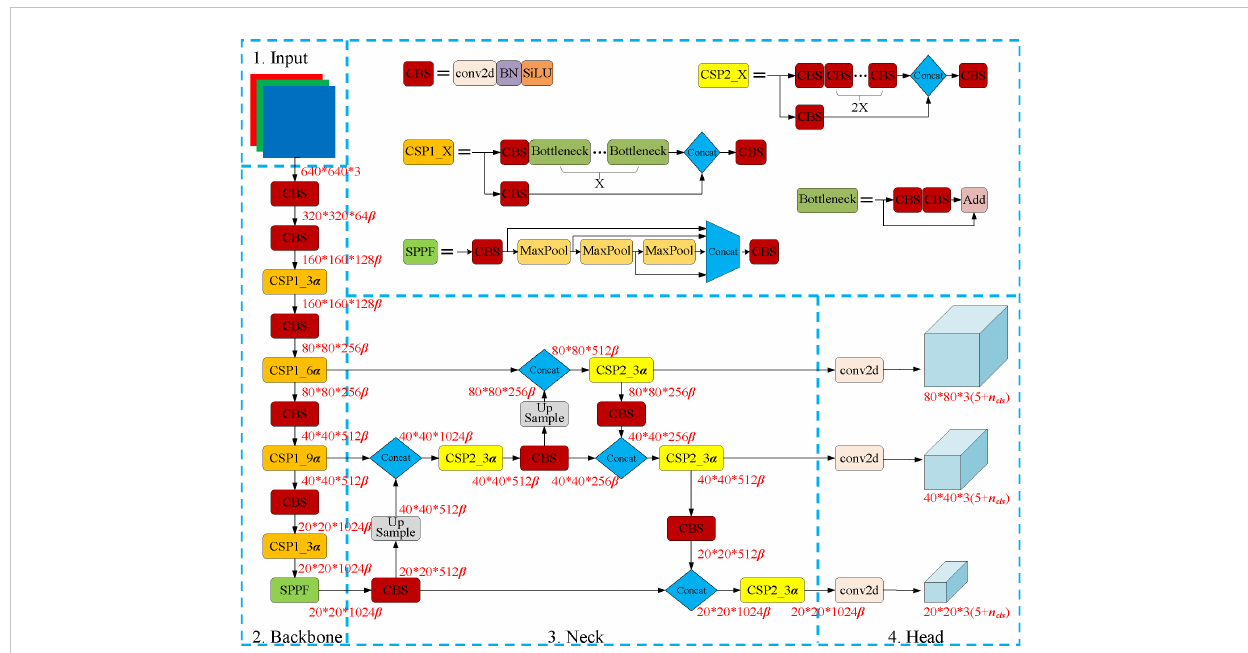
FIGURE 1 YOLOv5-v6.1 network structure diagram. a is the depth_multiple, b is the width_multiple, and n cls is the number of object classes. 640*640*3, 320*320*64 b etc. indicate the height*width*channels of the feature maps.